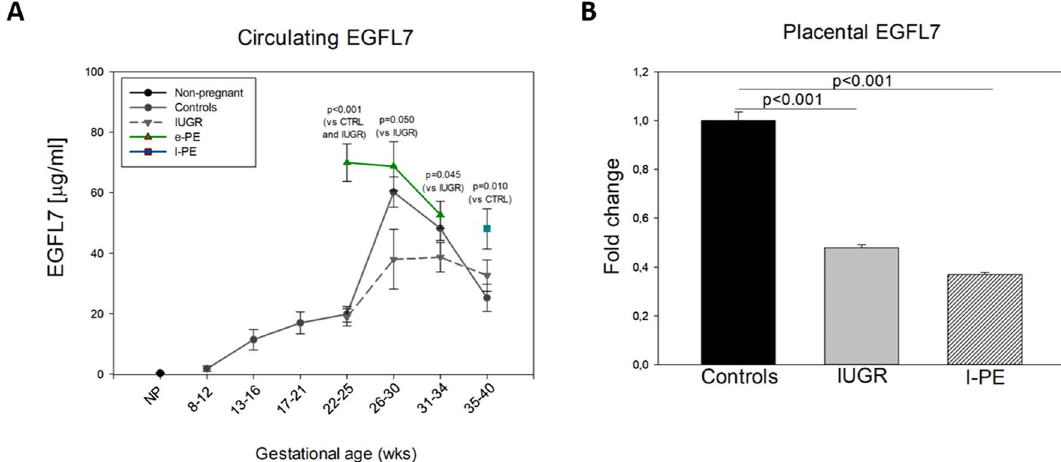
Figure 1. EGFL7 levels in non-pregnant women, healthy pregnant women, and pregnant women affected by IUGR, Early PE and Late PE. ( A ) Mean (± SE) levels of Epidermal Growth Factor-like Domain 7 (EGFL7) in plasma of non-pregnant women (NP), healthy pregnant women (Controls), IUGR-, Early PE- (e-PE) and Late PE- (l-PE) affected pregnant women throughout pregnancy as measured by ELISA. Data were compared using the two-sample t -test between two samples ( p < 0.001 for e-PE vs. CTRL and IUGR at GA 22–25; p = 0.05 for e-PE vs. CTRL and IUGR at GA 26–30; p = 0.045 for e-PE vs. IUGR at GA 31–34; p = 0.01 for l-PE vs. CTRL)